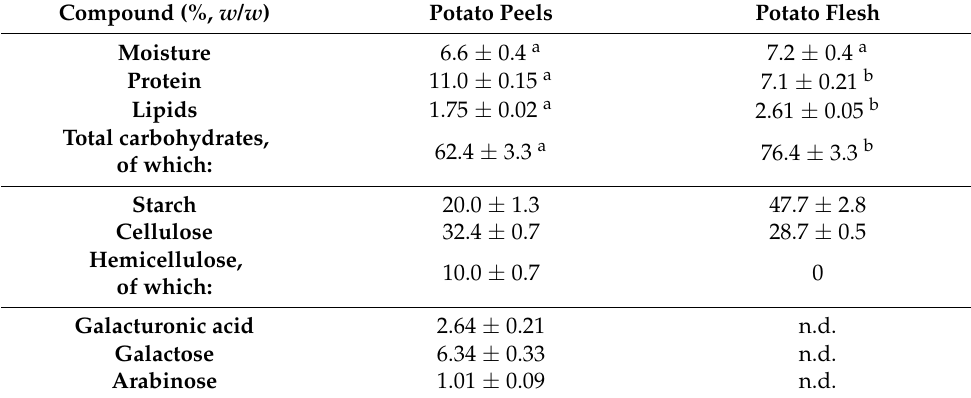
Table 1. Macronutrient composition of potato peels and flesh in d.b. (dry basis). Compound (%, w / w )